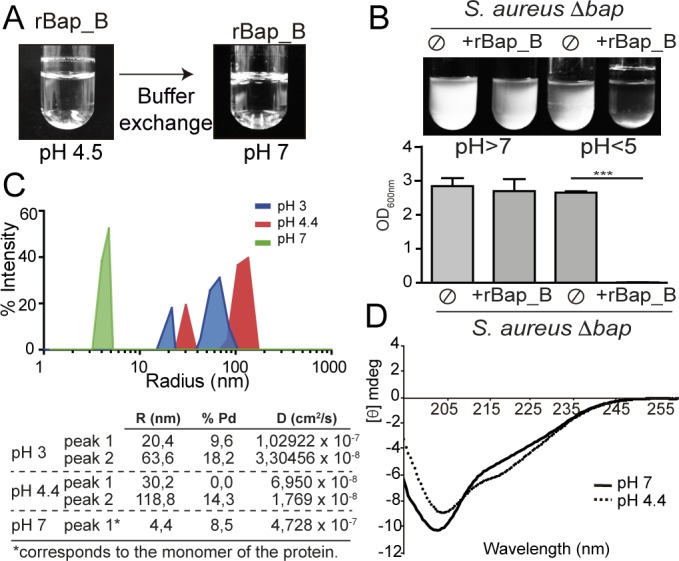
rBap_B aggregation propensity and secondary conformation at different pH.A) Purified rBap_B protein forms visible aggregates when incubated in phosphate-citrate buffer solution at pH 4.5. Reversion assay shows complete disassembly of rBap_B aggregates both at the bottom and on the top of the tube, after performing phosphate-citrate buffer exchange from pH 4.5 to pH 7. B) Bacterial clumping of S. aureus Δbap grown in LB-glu (pH<5) or LB (pH>7) incubated with 2 μM purified rBap_B protein. Ø, no addition of rBap_B. Cells were incubated for 24 h, with agitation at 37°C. Statistical analysis was carried out using the unpaired Student t test (***, P<0.001; n = 4). C) Hydrodynamic radius (R) of rBap_B in solution at different pH analyzed by dynamic light scattering. Table shows the diffusion coefficient (D) of each population and its corresponding radius (R). (Pd) polydispersity percentage of the corresponding detected population. D) Far-UV CD spectra of 0.2 mg/ml rBap_B at pH 7 (solid line) and pH 4.4 (dotted line).